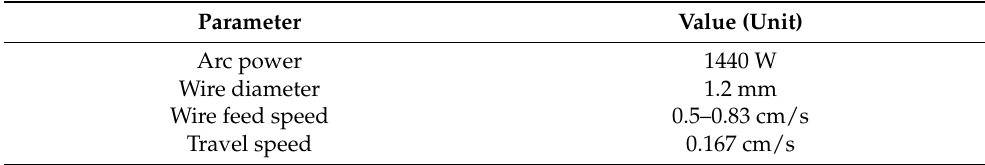
Table A2. Process parameters used in the